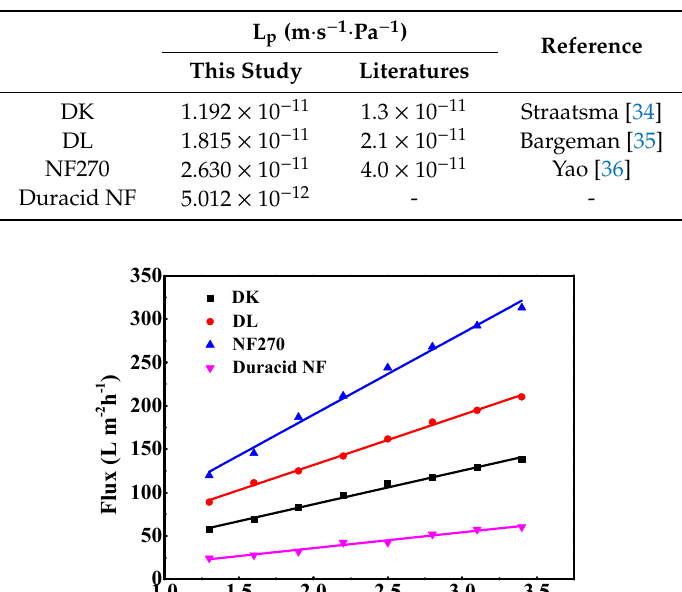
Table 3. Hydraulic permeability of four nanofiltration (NF) membranes.